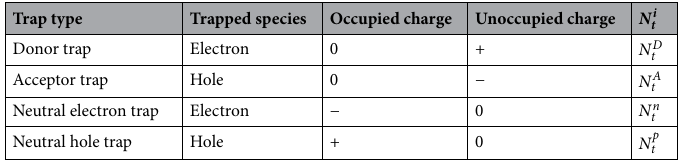
Table 1. Defect types with respect to i subscript in Eqs. (5) and (6) 61,65 .